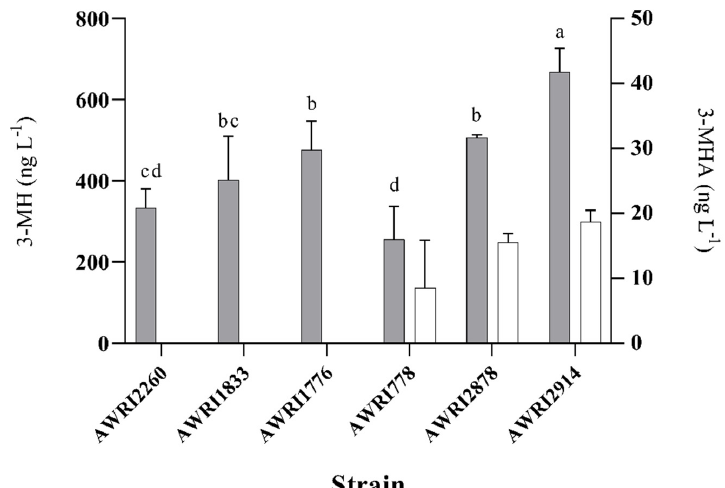
Figure 5. Concentration of 3-MH (grey) and 3-MHA (white) in Grenache wines fermented with 6 yeast strains with different IRC7 genotypes, after 9 months in bottle. Each bar (in ng L − 1 ) represents the mean and standard deviation of three independent fermentation replicates. The 6 yeast strains are shown in ascending order according to their specific β -lyase activity. Means with the same superscript letter are not significantly different from each other (Tukey’s test, p < 0.05). Wines made with AWRI2914 exhibited the highest 3-MH and 3-MHA concentrations (662 and 18.9 ng L − 1 , respectively), consistent with its high β -lyase activity. Wines made with the four low β -lyase activity strains averaged 363 ng L − 1 of 3-MH, with only one of these strains, AWRI778, producing quantifiable amounts of 3-MHA (8.5 ng L − 1 ). AWRI2878, the moderate β -lyase activity strain, produced intermediate levels of 3-MH and 3-MHA (508 and 15.5 ng L − 1 , respectively). As in the Pinot Noir experiments, no de- tectable levels of 4-MMP could be found in any of the Grenache wines.